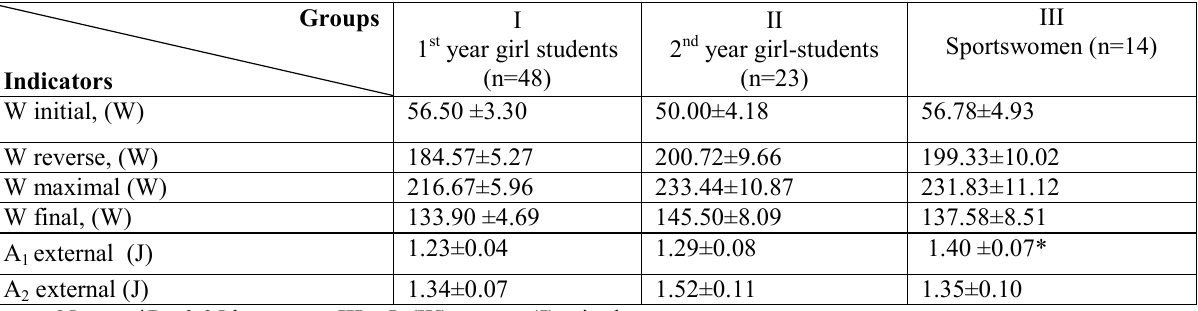
Level of functional reserves’ mobilization of junior students by indicators of organism’s energetic level under load